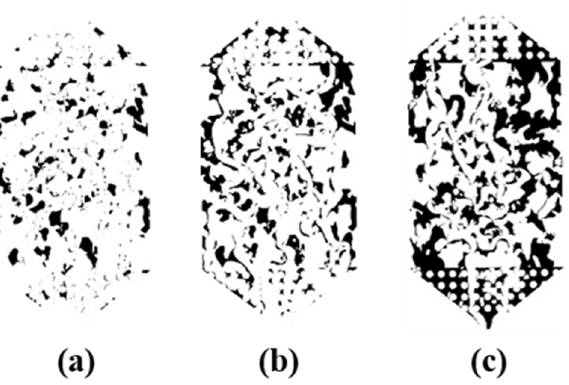
Figure 14. cryo-SEM images of fracturing fluid ( a ) 0.1 wt%, ( b ) 0.8 wt%, ( c ) 1.2 wt%.